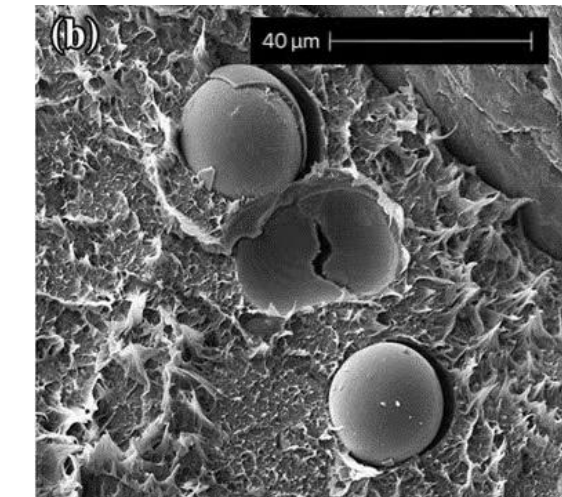
Figure 13. Interface diagram and partially enlarged figure of a composite with a coupling agent. ( a ) Mag = 1900×; ( b ) Mag = 1000×. Adapted with permission [63], Copyright 2016, Springer. The study on the thermal properties of epoxy resin-based syntactic foams was carried out from the perspective of different composites, and the related theory of glass bead filler was used to analyze the problems. The traditional research mode of simple blending was broken through, so that the study on thermal properties of epoxy composite foam could be solved from a new perspective. After modifying glass microspheres, the interface con- nection between HGM and the substrate can be changed from simple physical miscibility to a strong chemical bond. The microsphere and matrix are better connected [66 – 68], giv- ing the composite unique physical and chemical properties. As in-depth research is con- ducted on microspheres, better epoxy-based composite foam insulation materials will be further explored. 3.3. Filling Modification of Negative CTE Due to the porous structure, epoxy-based composite foams exhibit a higher CTE than most polymer materials. Close to room temperature, the linear expansion coefficient of epoxy-based foam is 40 – 80 ppm/K which is also much higher than that of common metal- lic and ceramic materials. Therefore, when such materials are used, there is a large CTE mismatch with other materials. Especially after many thermal cycles, the two materials generate greater stress at the contact surfaces, which can cause the instability of device performance [69].